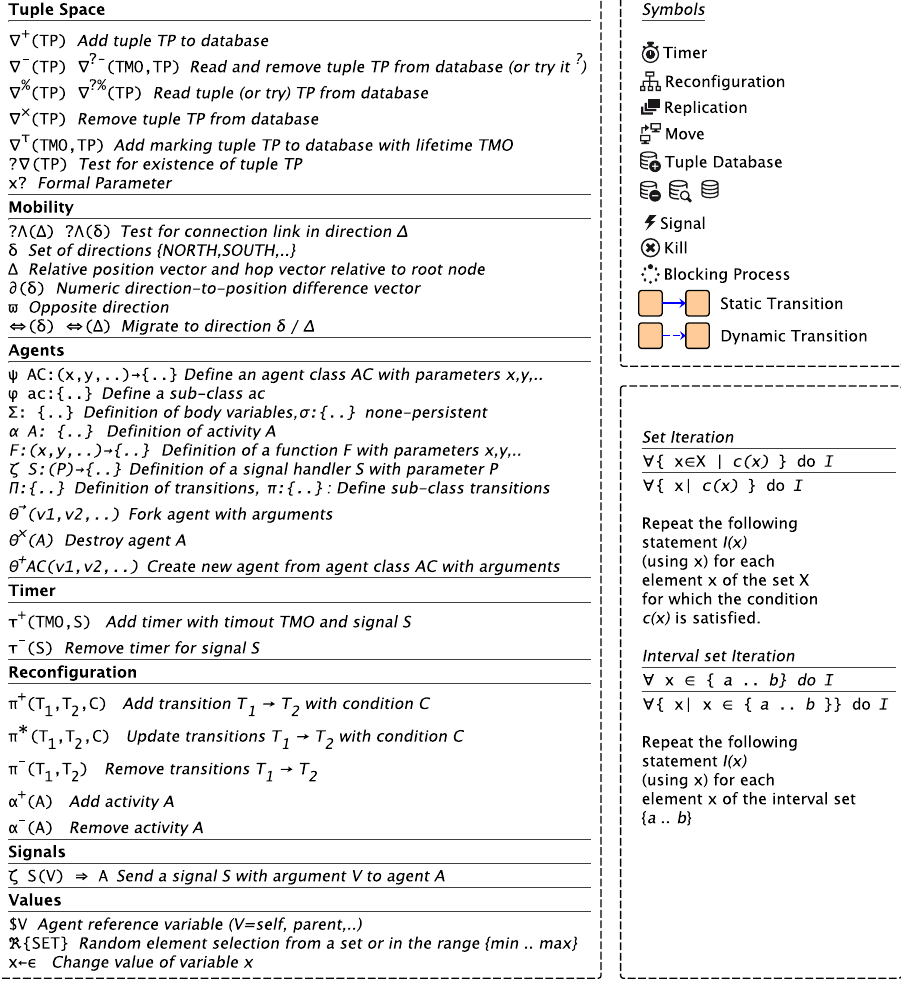
Figure A1. AAPL short notation and symbols related to the dynamic ATG and agent interaction